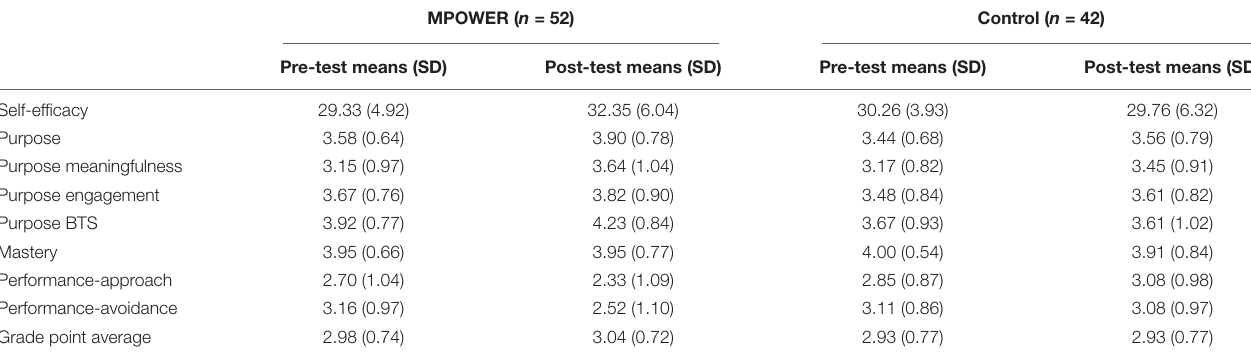
TABLE 1 | Means and standard deviations at pre-test and post-test for intervention and comparison groups.